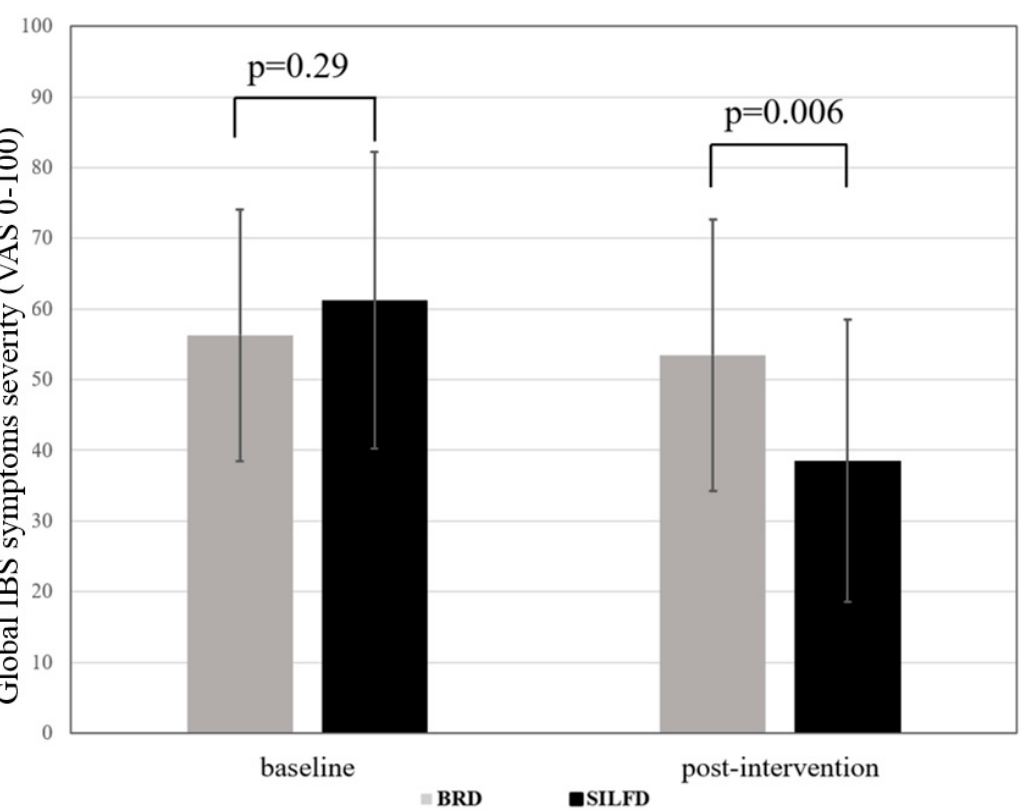
Figure 3. Global IBS symptom severity score comparing structural individual low-FODMAPs diet advice (SILFD) and brief advice on a commonly recommended diet (BRD) for IBS patients. VAS: visual analog scale.